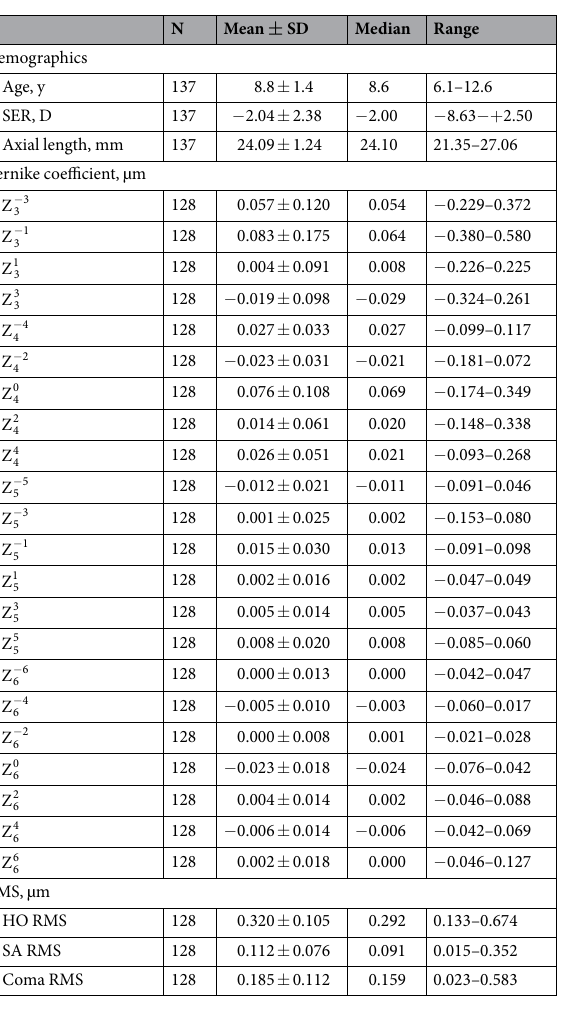
Table 1. Baseline demographics, individual Zernike coefficients and RMS of higher-order aberrations of the pooled population. SER: spherical equivalent refraction; HO RMS: RMS of total higher-order aberrations (3rd to 6th orders inclusive); SA RMS: RMS of spherical-like aberrations ( Z 40 and Z 60 combined); coma RMS: RMS